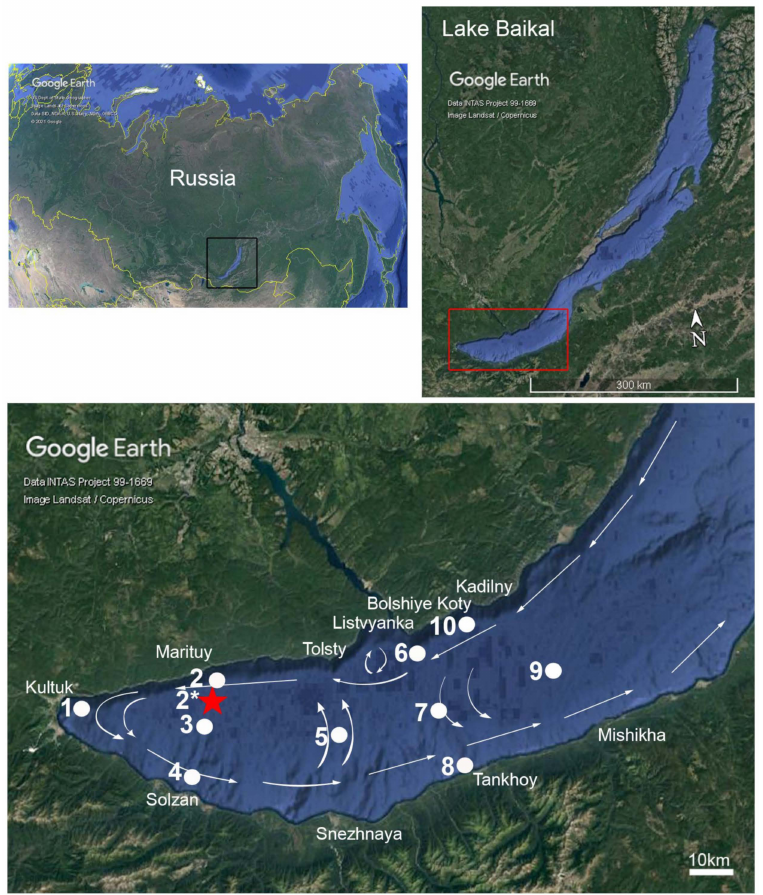
Figure 1. Map of the study area (South Baikal). Numbers: sampling stations (see Supplementary Table S1); the star marks the station at which the high diatom abundance was observed in summer 2019. The arrows show a scheme of the average currents in the 15–50 m layer during the ice-free period [23]. Maps were taken from the «Google Earth Pro» software (https://www.google.com/ intl/ru/earth/versions/#earth-pro, accessed on 29 April 2021). «Inkscape» (https://inkscape.org/, accessed on 29 April 2021) free graphics editor was used to edit images and apply additional marks to